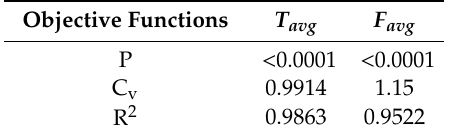
Table 4. Comparison of fitting accuracy indicators of response surface models.